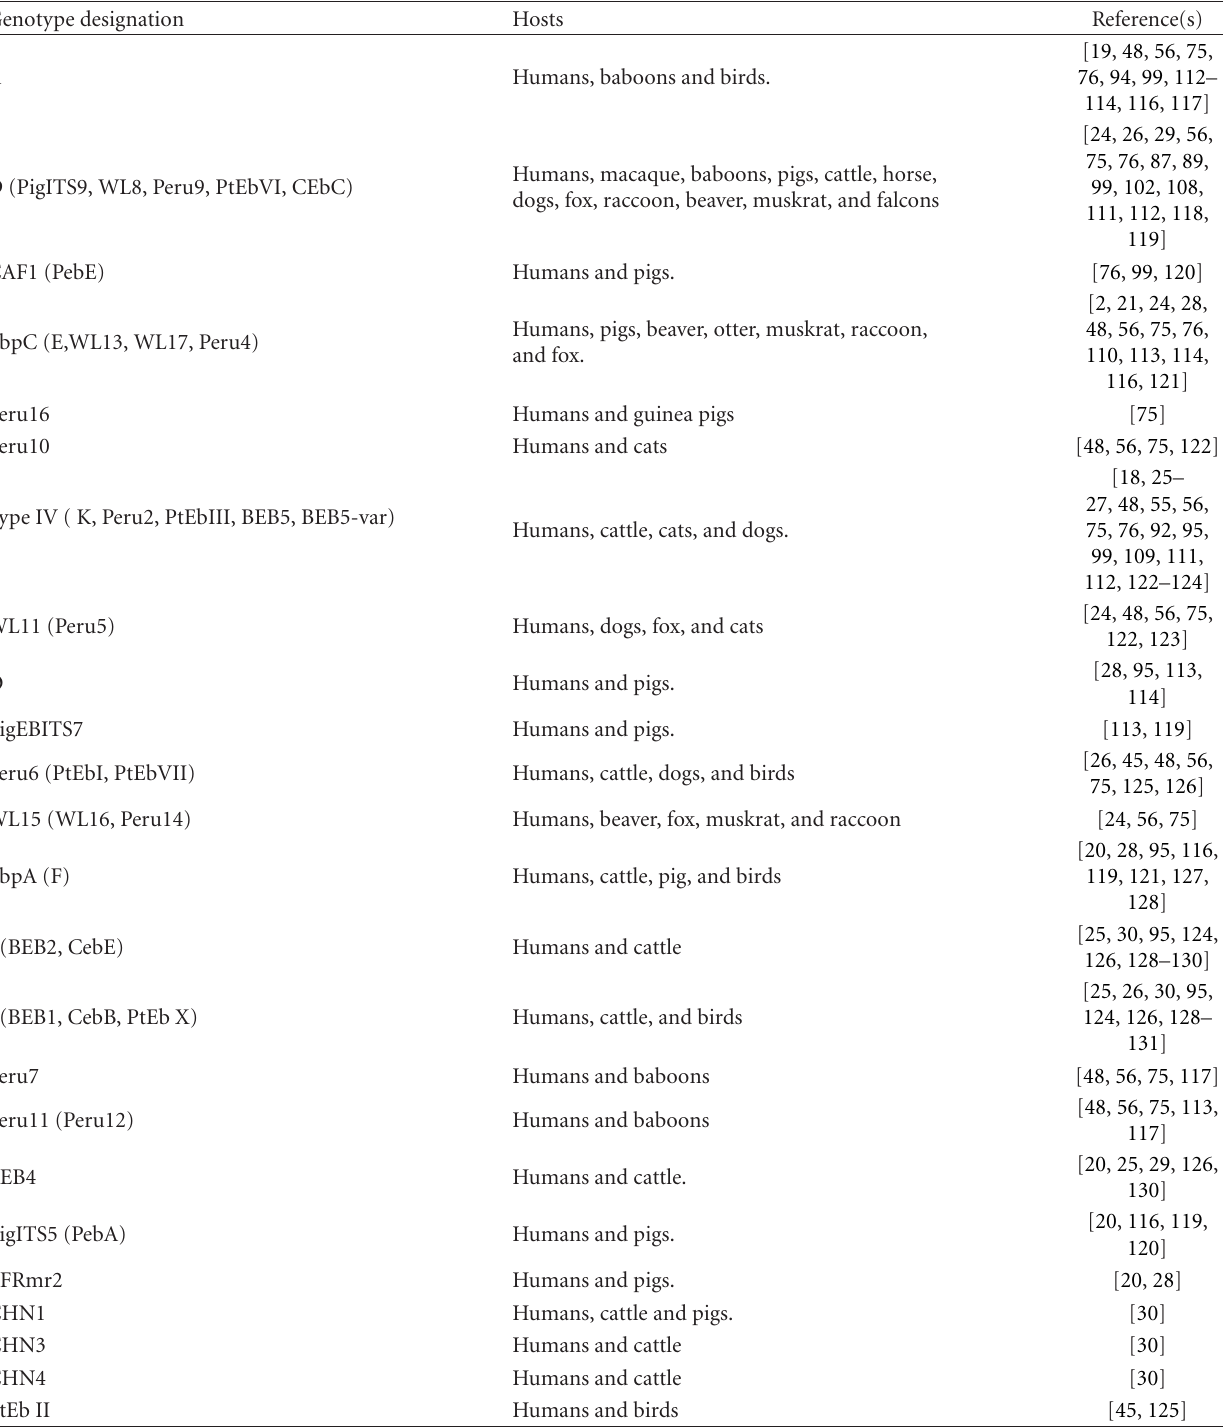
Table 4: Enterocytozoon bieneusi zoonotic